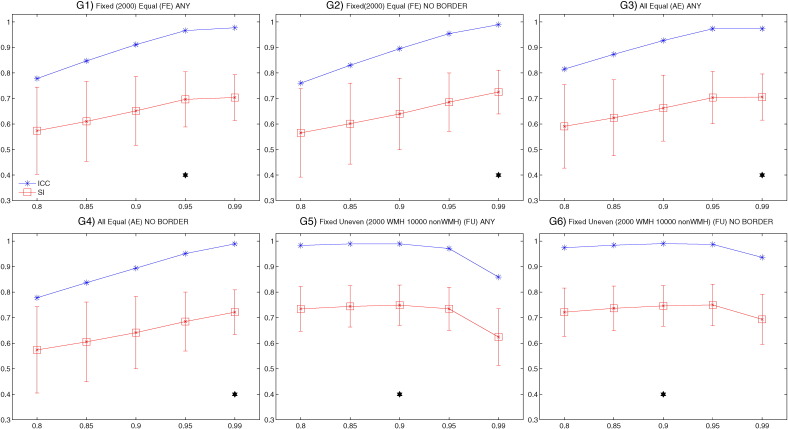
BIANCA optimisation phase I (Dataset 1) – threshold optimisations (option G in the main text). The plots show the values of the main metrics used to evaluate BIANCA performance using different values (x axis) for the different options (please refer to the main text and supplementary table S1 for details about the options). The similarity index (SI) is shown in red, with mean value (square marker) and standard deviation (error bars) across subjects. The intra class correlation coefficient (ICC) between the total WMH volume from BIANCA output and manual segmentation is shown in blue. The black stars indicate the value(s) chosen for a specific option.